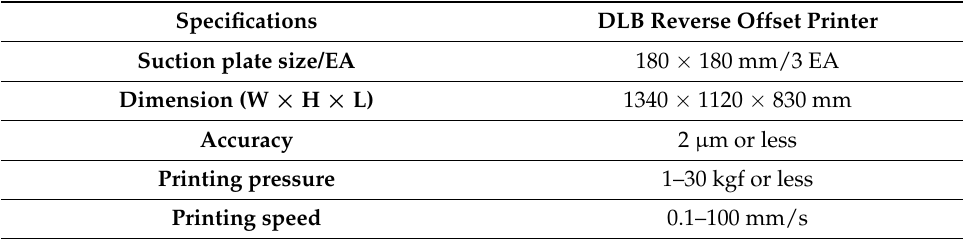
Figure 2. ( a ) Drawings of the DLB reverse offset printer and ( b ) manufactured printer. ( c ) Structure (cross-sectional views) and image comparison of the ( i ) DLB blanket roll and ( ii ) conventional blanket roll. ( d ) Schematic illustrating the separation of the blanket coated with ink film after applying pressure to the clich é . ( e ) Image of the ink film transferred from bottom substrate to the DLB. Table 1. Specifications of the DLB reverse offset